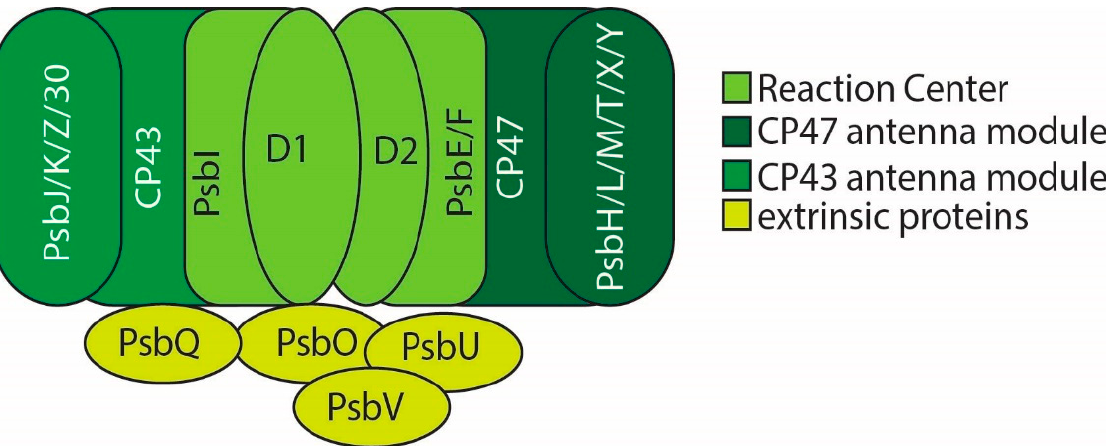
Figure 1. PSII monomer (PSII forms a dimer in vivo). Modules are colored as indicated. The PSII reaction center (RC) is localized on the D1 and D2 protein subunits. These subunits bind the P680 reaction center chlorophyll special pair as well as the primary electron transfer chain, including plastoquinones Q A and Q B and the catalytic Mn 4 CaO 5 water-oxidizing complex (WOC or OEC for oxygen evolving center). The PsbI subunit and cytochrome b559 (made up of the PsbE and PsbF subunits) complete the reaction center. This reaction center complex has been isolated independently and is the smallest PSII sub-complex capable of charge separation [19–21]. It is notable, however, that the CP43 subunit also provides a ligand to the manganese cluster, and so, while capable of charge separation, the reaction center proteins alone are not sufficient to bind the catalytic metal center or perform water-oxidizing